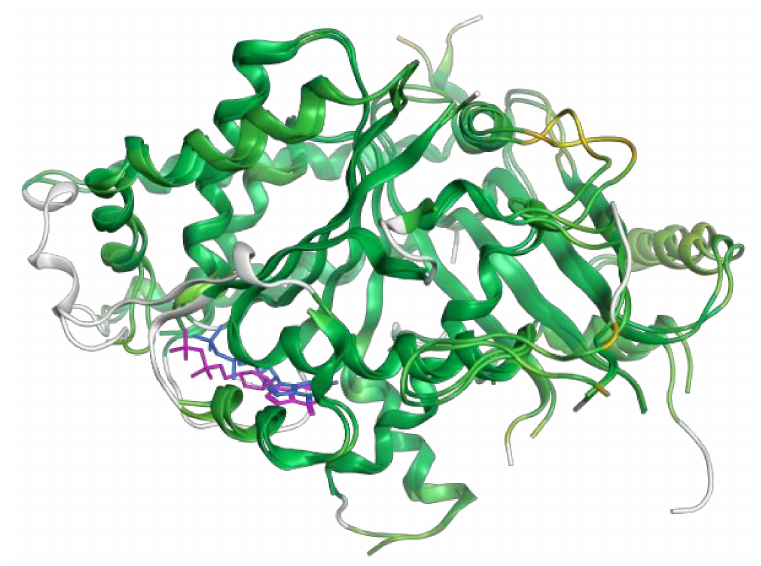
Figure 6. The structures of γ tubulin from PDB 3CB2 and 6V5V entries are superimposed and color-coded according to RMSD: a deeper shade of green indicates a lower RMSD value.